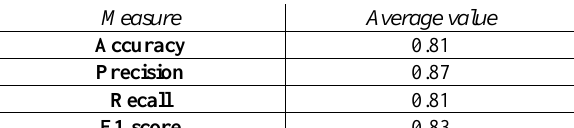
Table 1: Statistics of the testing phase.